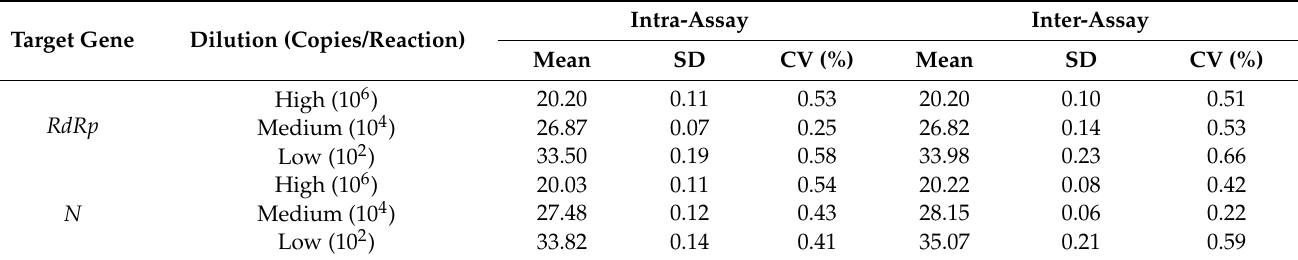
Table 3. Intra- and inter-assay coefficient of variation of